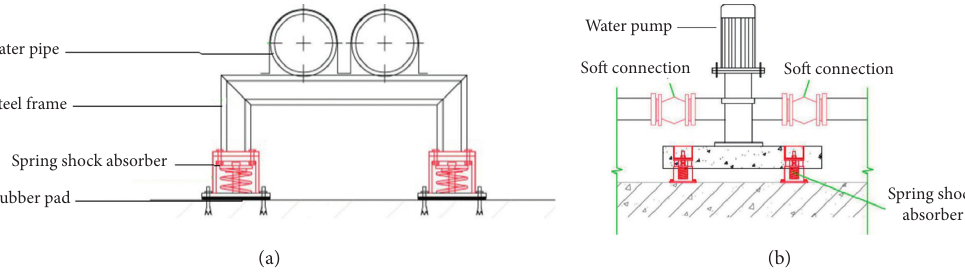
Figure 3: The schematic diagram of vibration isolation of the water pipe and the water pump.